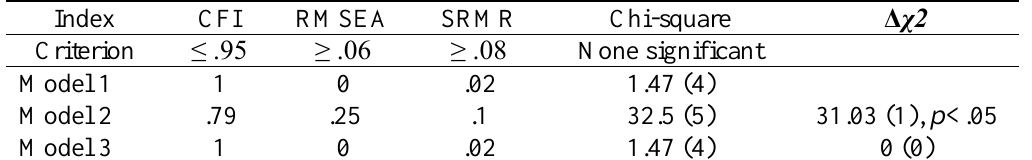
Summary of model fit indices for Ellis and Loewen